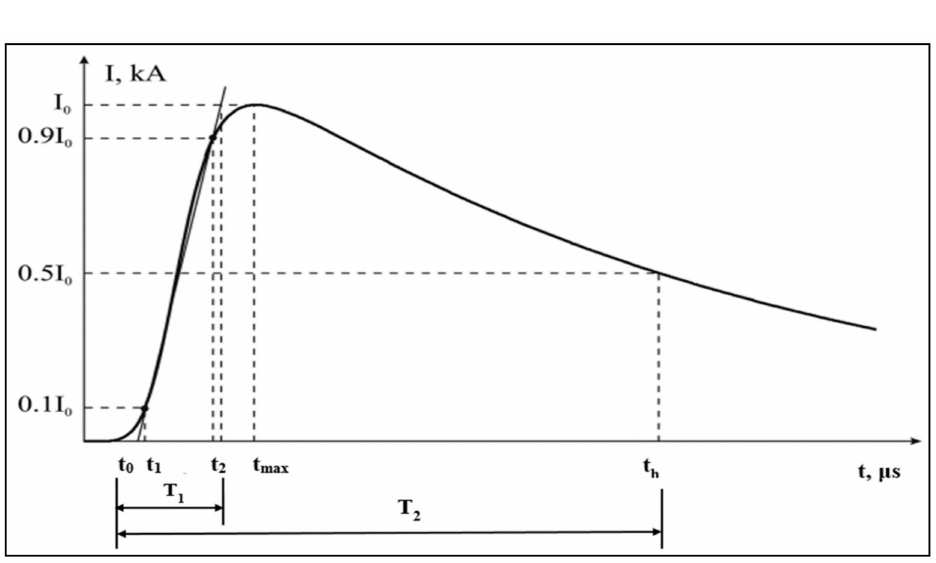
Figure 7. Lightning current approximation by Heidler function